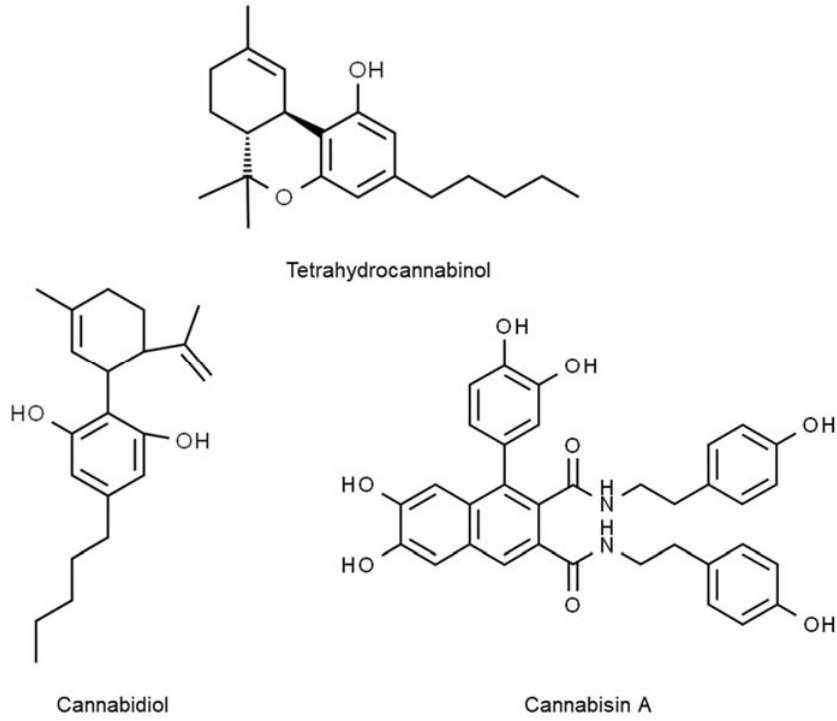
Figure 4. Polyphenolic compounds in hemp seed.